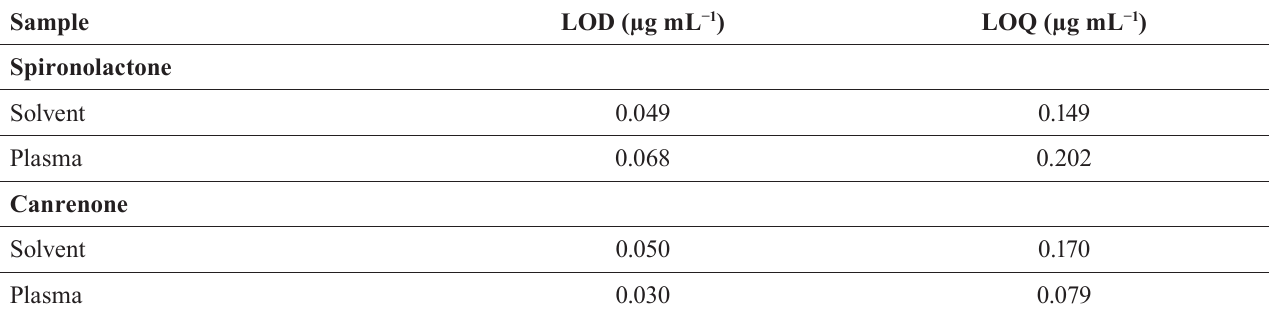
TABLE I – L imits of detection (LOD) and quantification (LOQ) for spironolactone and canrenone in solvent and plasma